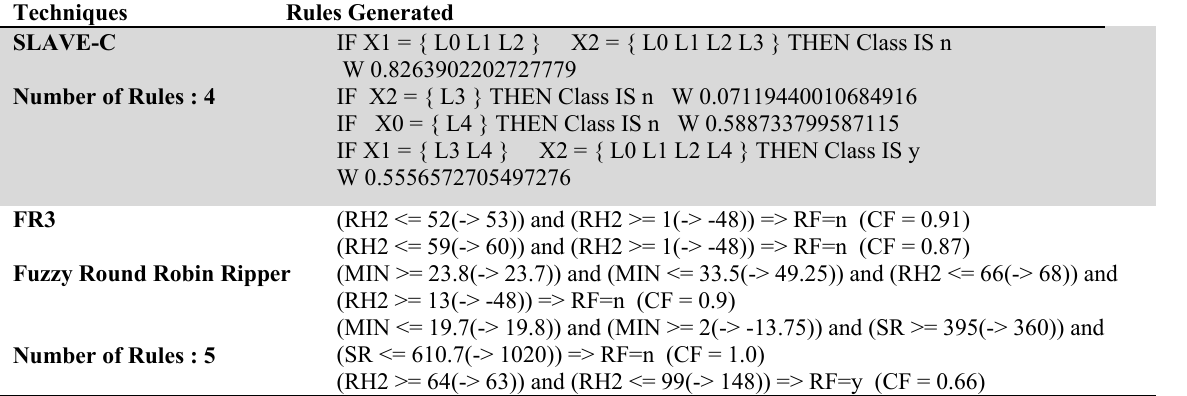
Fuzzy association rules for classification Techniques Rules